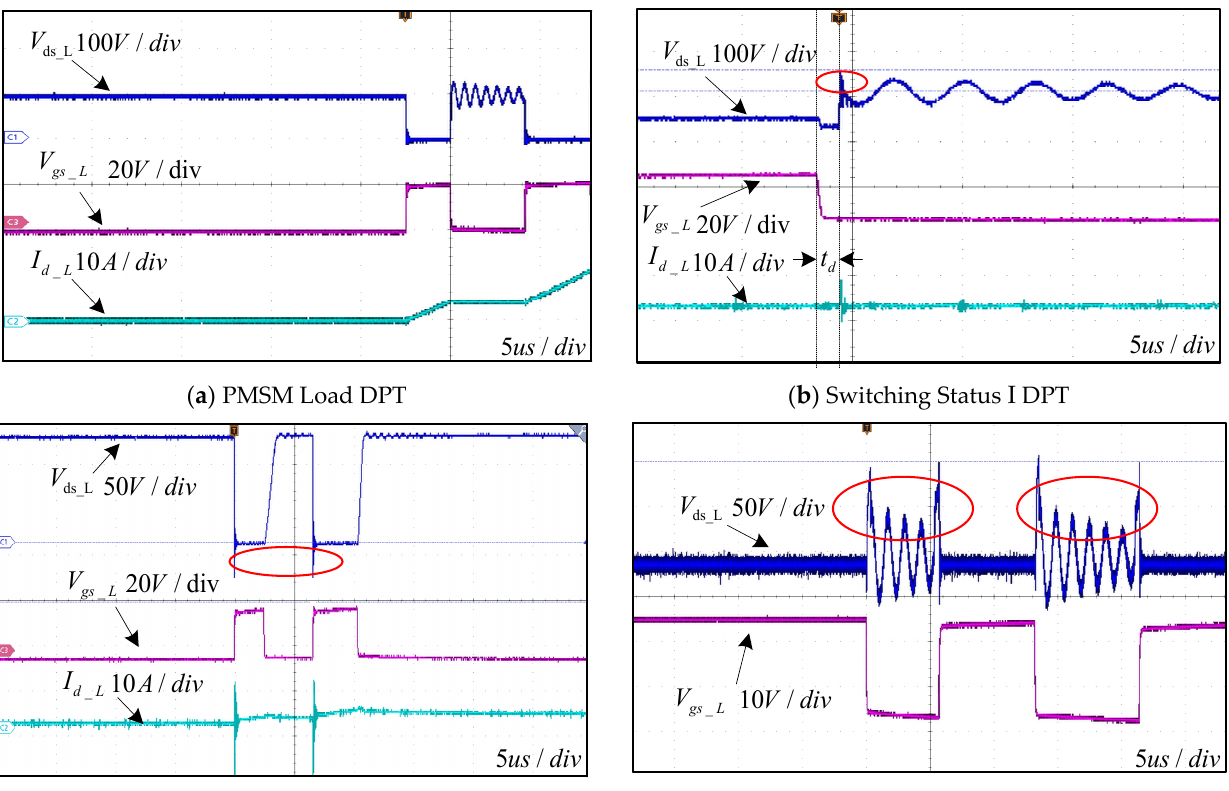
Figure 3. Double ‐ pulse test results. Figure 3. Double-pulse test